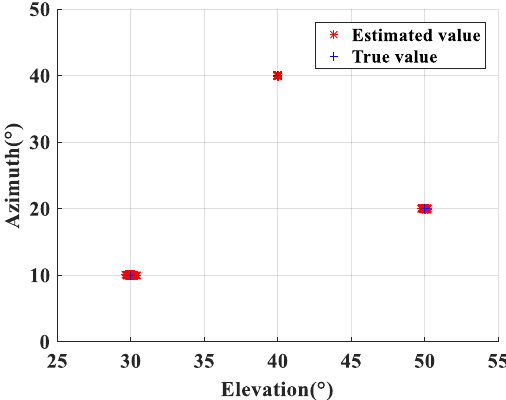
Figure 4. Planisphere of the azimuth angle and elevation angle: SNR = 20 dB, snapshot